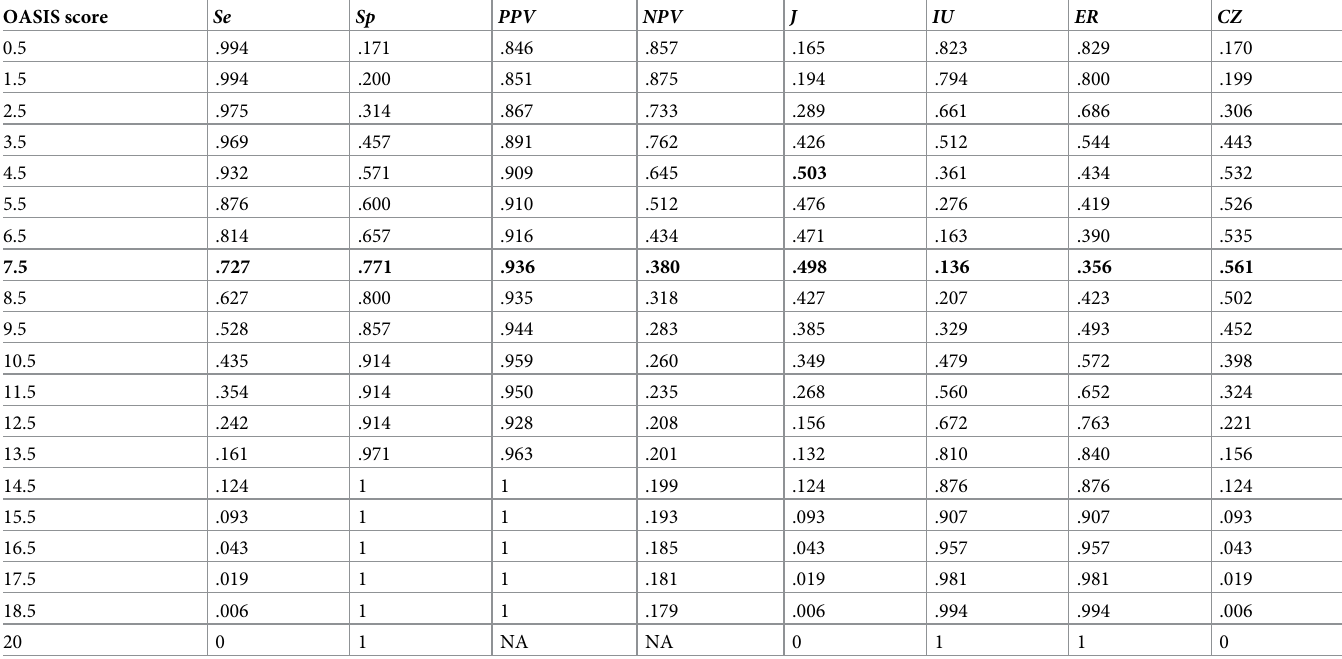
Table 6. Statistics to assess the diagnostic accuracy of the OASIS scores. OASIS score